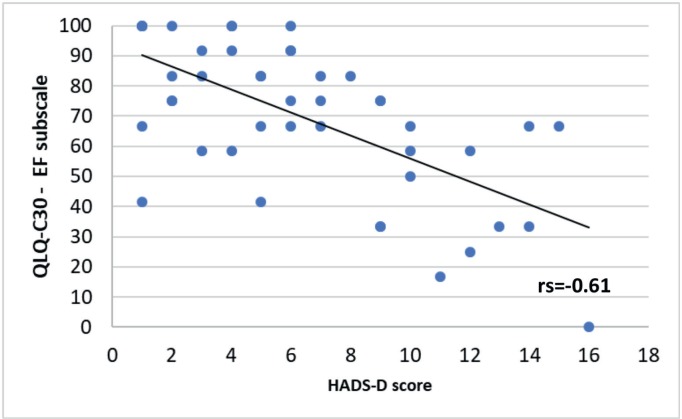
Correlation between HADS-D and the emotional functioning (EF) subscale of EORTC QLQ-C30.